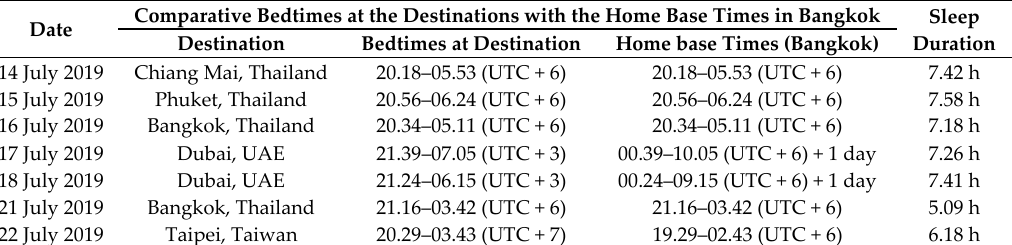
Table 12. Analyzed data from the Fitbit application of the 2nd Female Flight